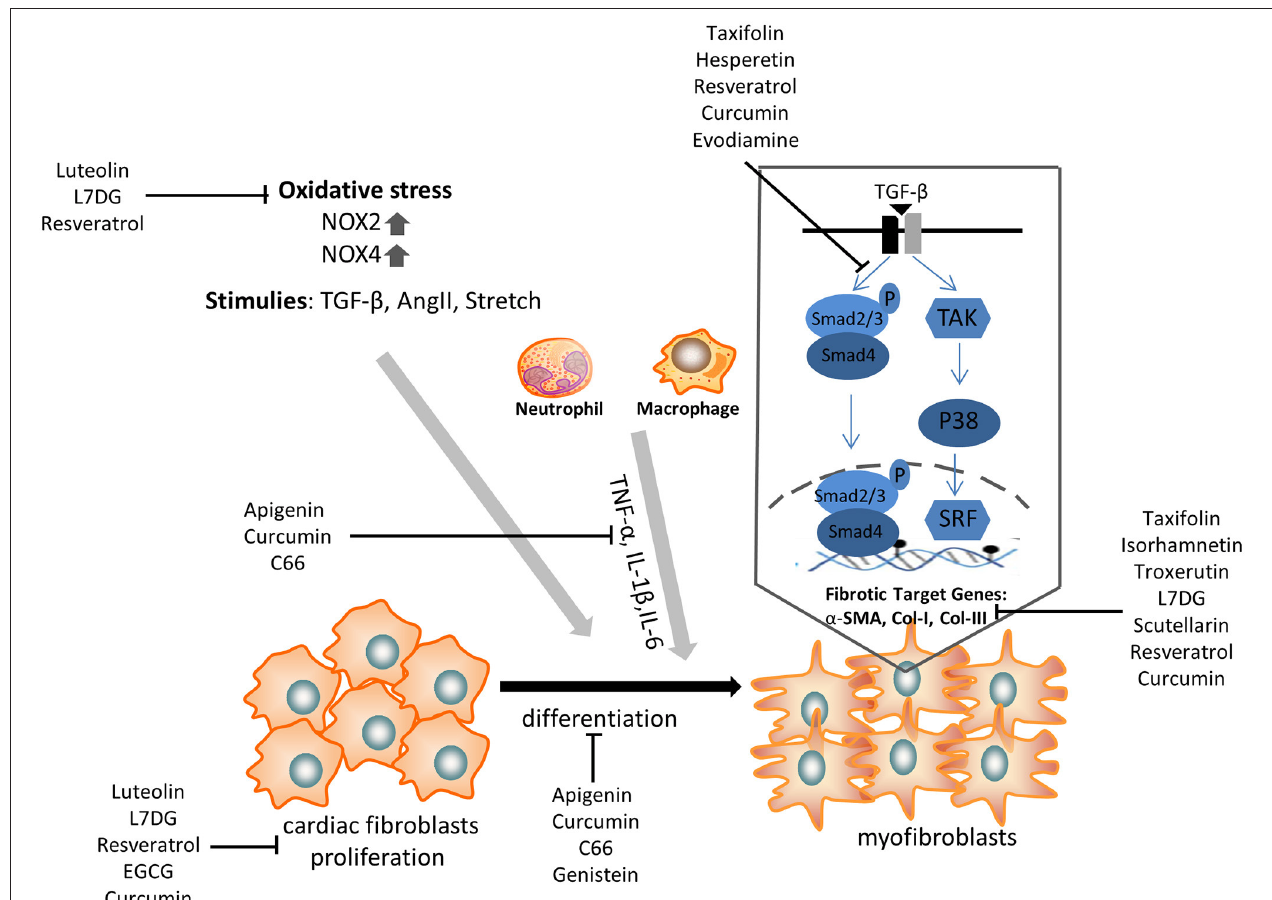
FIGURE 2 | The anti-fibrotic effect of some selected polyphenols on cardiac fibroblasts proliferation, transdifferentiation, extracellular matrix deposition, and TGF- β /smad signaling pathway. α -SMA, α -smooth muscle actin; NOX, NAPDH oxidase; TNF, tumor necrosis factor; IL, interleukin; TGF, transforming growth factor; L7DG,